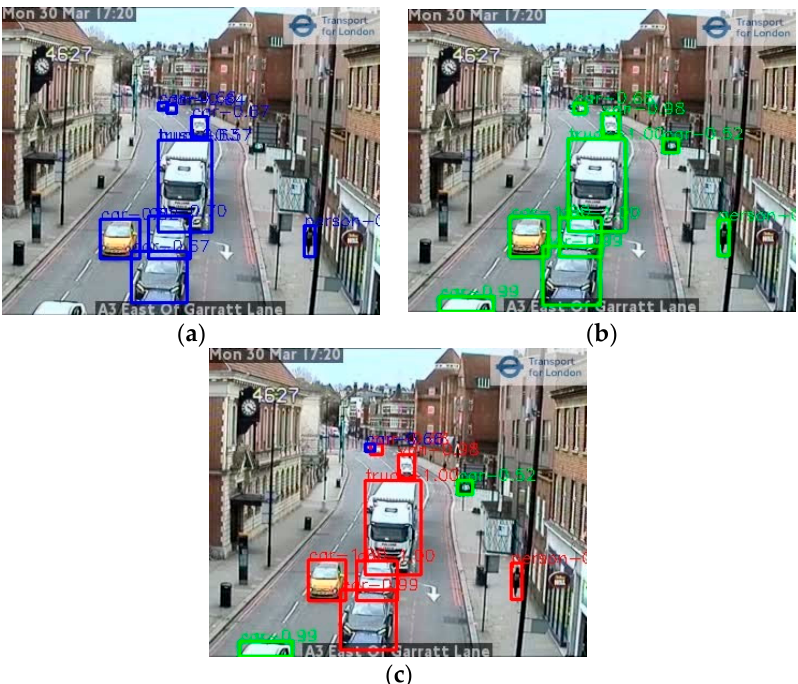
Figure 13. Example of object detection using an ensemble method; ( a , b ) Annotations detected by the Faster-RCNN and YOLOv5x models independently, respectively; ( c ) the result of combining the results in an ensemble. In ( c ), red boxes show objects detected by both models; green boxes are objects detected by Faster-RCNN but not YOLOv5x, and blue boxes are objects detected by YOLOv5x but not Faster-RCNN. (image TfL Open Data).